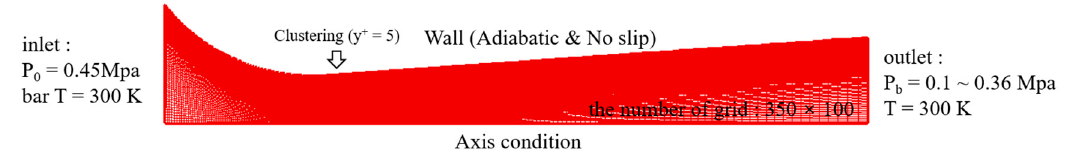
Figure 5. The geometry of the toroidal-throat Venturi nozzle and the computational grids with boundary conditions applied for axisymmetric Reynold-Averaged Navier–Stokes (RANS) simulation.